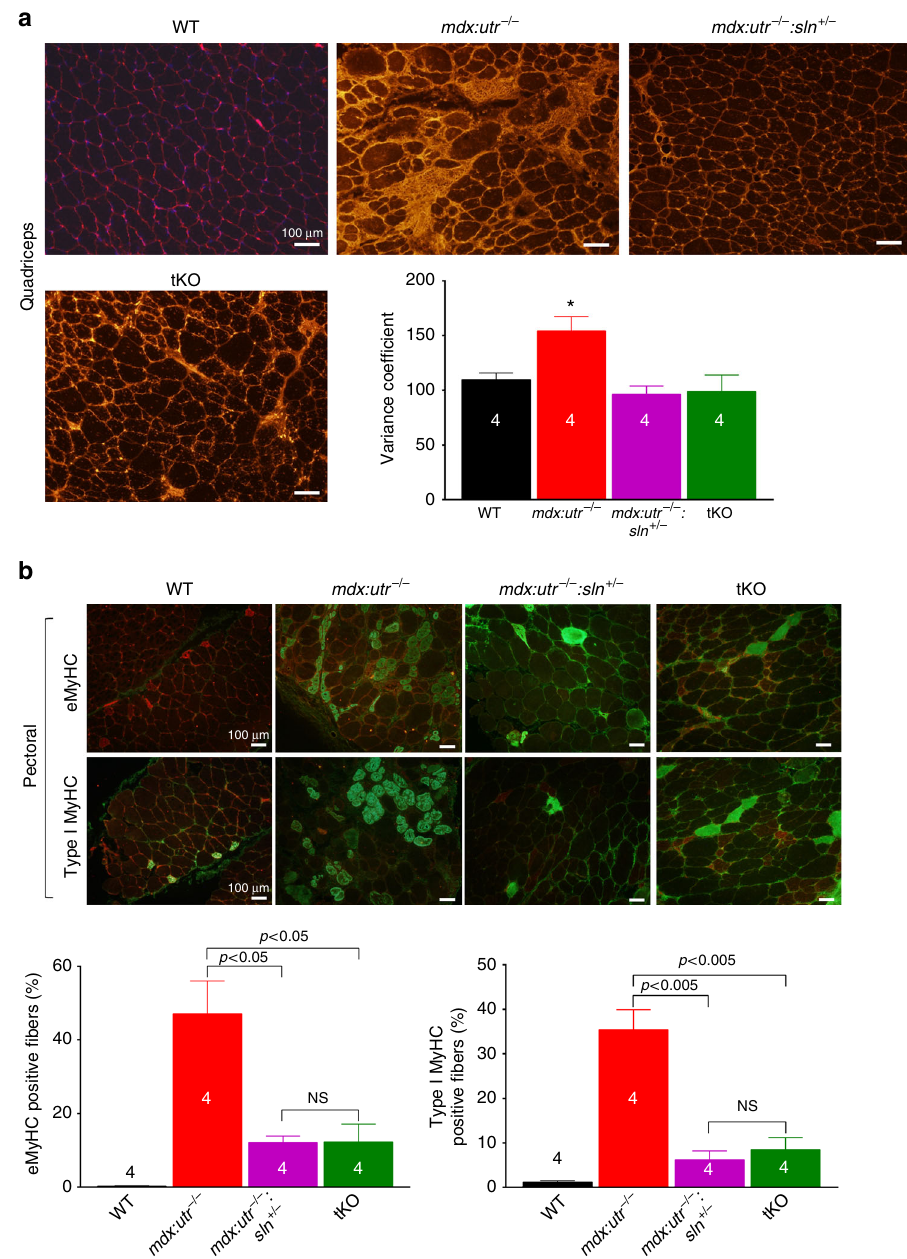
Fig. 3 Reduction in SLN expression improves muscle regeneration and prevents fi ber-type transition. a Representative images of WGA stained sections of quadriceps used for fi ber size measurements. Original magni fi cation is ×10. The measurements of minimal “ Feret ’ s ” diameter variance coef fi cients (VC) of the muscle fi ber size shown in the bar graph indicates that VC of fi ber size is signi fi cantly reduced in the quadriceps of mdx:utr − / − :sln + / − and tKO mice. Data are presented as mean ± SEM of four independent experiments. *signi fi cantly different from other groups ( p < 0.05, t -test with Welch ’ s correction). Scale bar = 100 μ m. b Representative images of pectoral muscle sections immunostained for eMyHC (green) or Type I MyHC (green) and stained with WGA (red). Original magni fi cation is ×10. Scale bar = 100 μ m. The quantitation of muscle fi bers positive for eMyHC and Type I MyHC are shown in the bar graph. The n number for each group and the p values ( t -test with Welch ’ s correction) are shown within the graph. Data are presented as mean ± SEM. NS-not statistically signi fi cant. Tissues from 3 to 4 month old mice are used for all the above